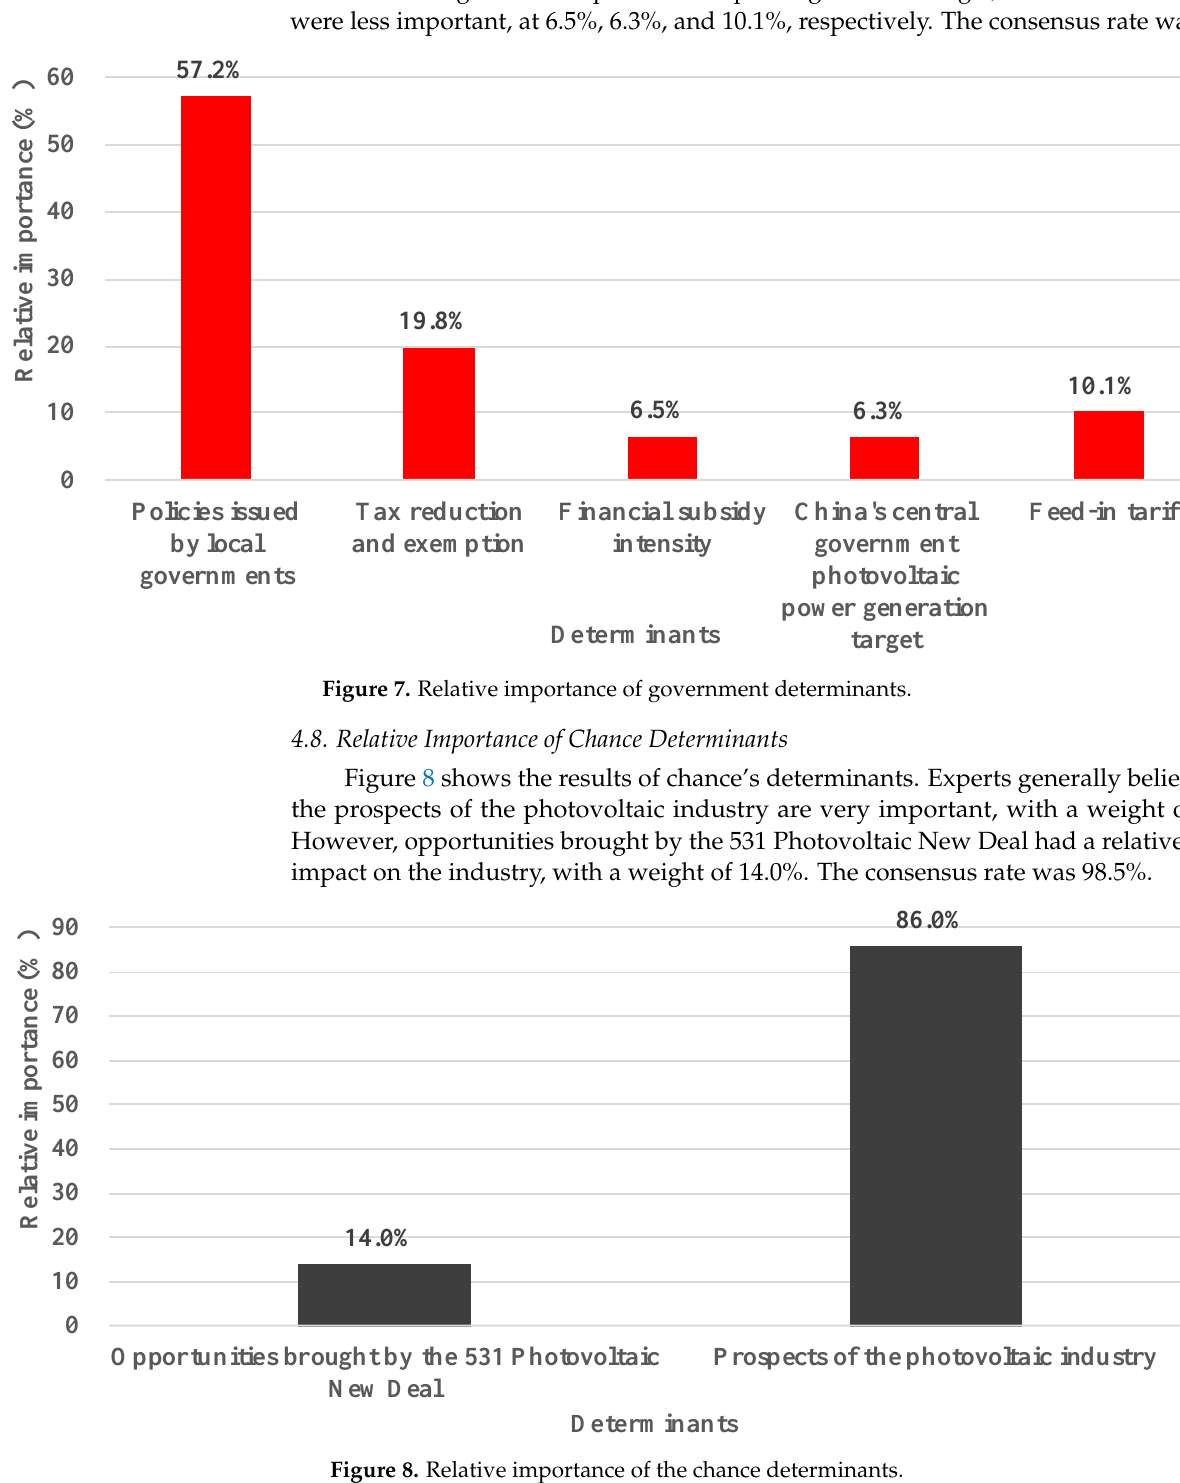
Figure 6. Relative importance of the related and support industries determinants.